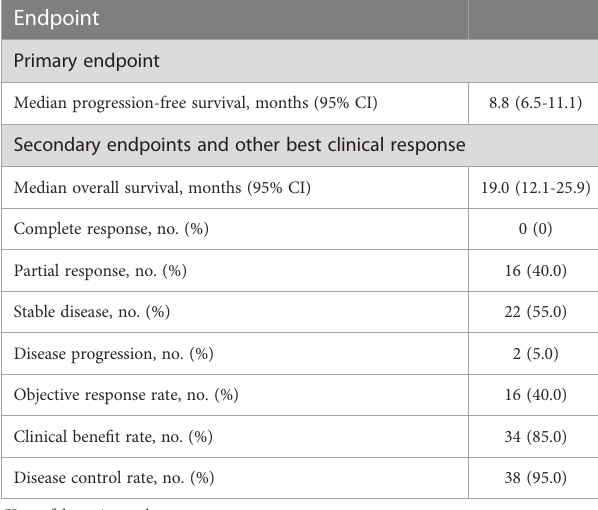
TABLE 2 Ef fi cacy outcomes